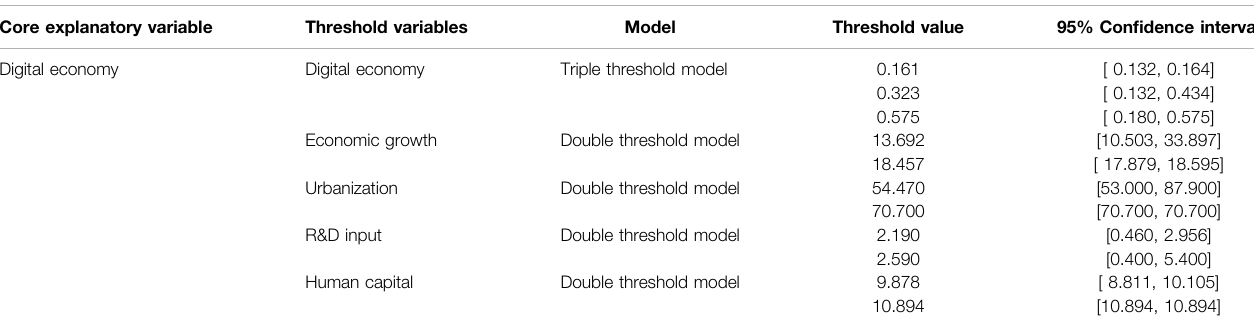
TABLE 10 | Threshold estimates value and con fi dence